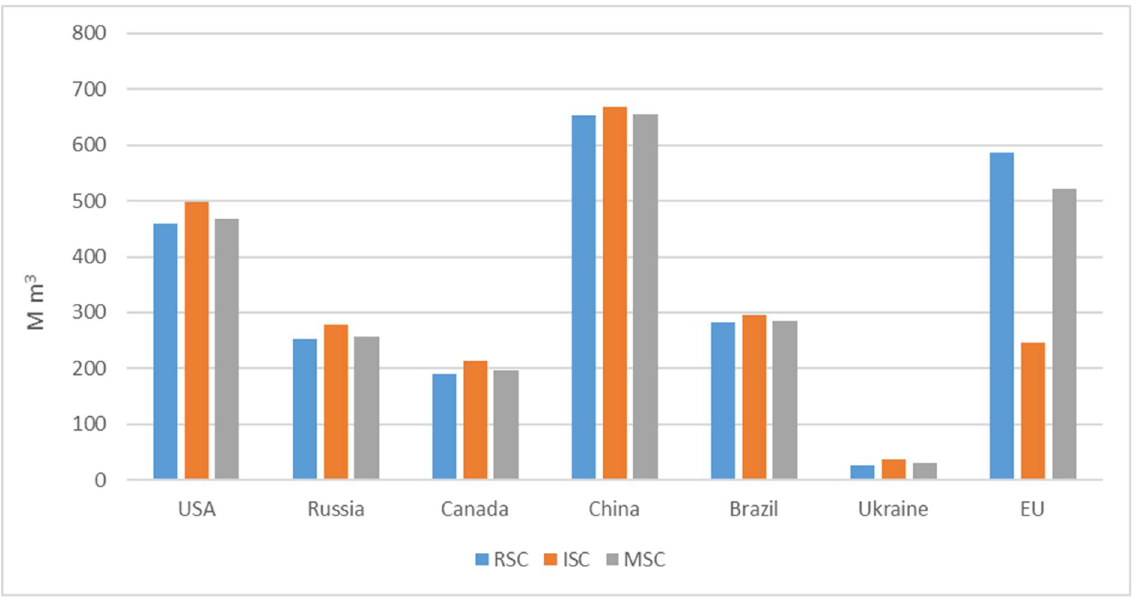
Figure 6. Roundwood production in countries with the greatest changes (ranking of countries is according to changes in ISC vs. RSC) and the EU: RSC (blue), ISC (orange), and MSC (grey) in 2050 [authors’ results].